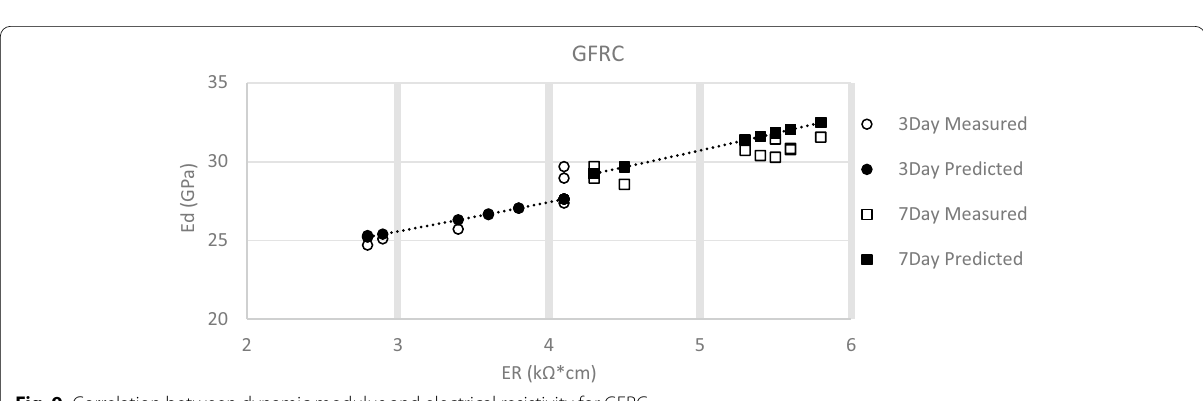
Fig. 8 Correlation between observed Ed and projected Ed for SRFC at early ages.